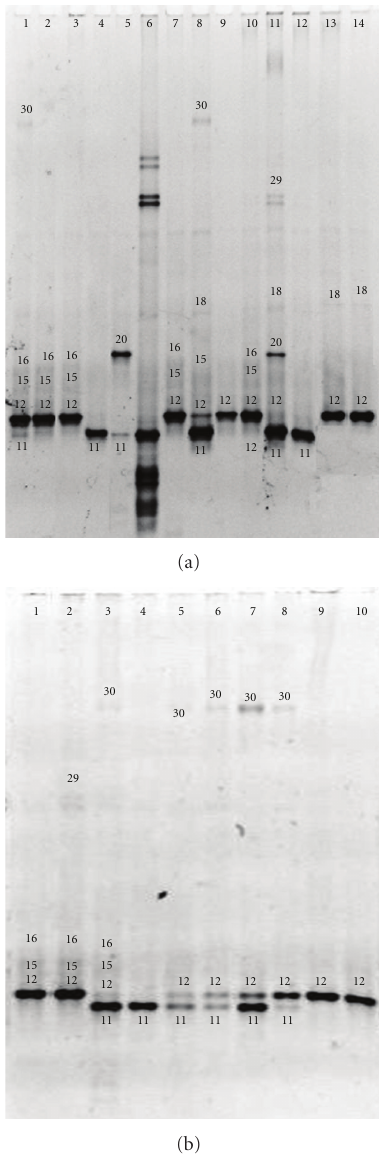
Figure 2: Denaturing gradient gel electrophoresis of vaginal samples from second trimester. Gel A ( n = 12); lines 2–5, 7–11, and 13–15 samples. Lines 1,6,12 internal DNA lab-standard. Gel B ( n = 13); lines 1–5 and 7–14 samples. Line 6 internal DNA lab-standard. Number of DNA-band in the figure related to Table 2, where the percentage of identification in women studied and GenBank access number data identification are described.